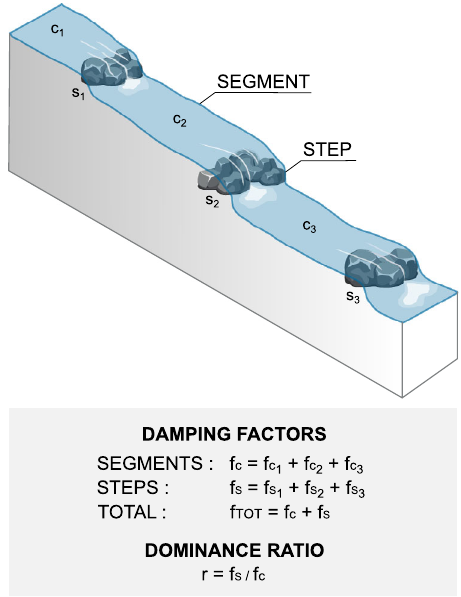
Fig. 2 | Schematic of the decomposition of a reach into segments and steps. De fi nition and aggregation of the damping factors f C and f S within a complex sys- tem,whichleads to the expressionof the dominance ratio r . Image generated with